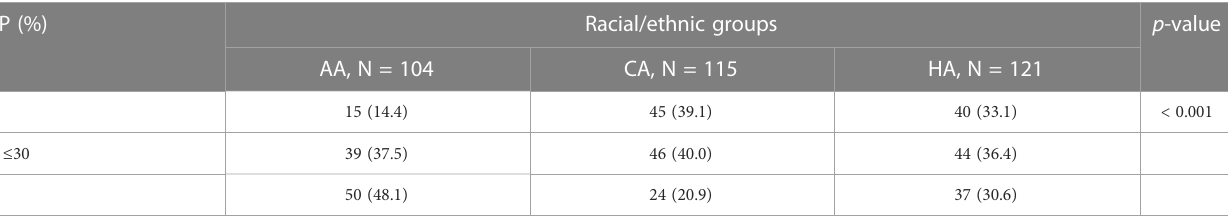
TABLE 3 Levels of BOP in different racial/ethnic groups.